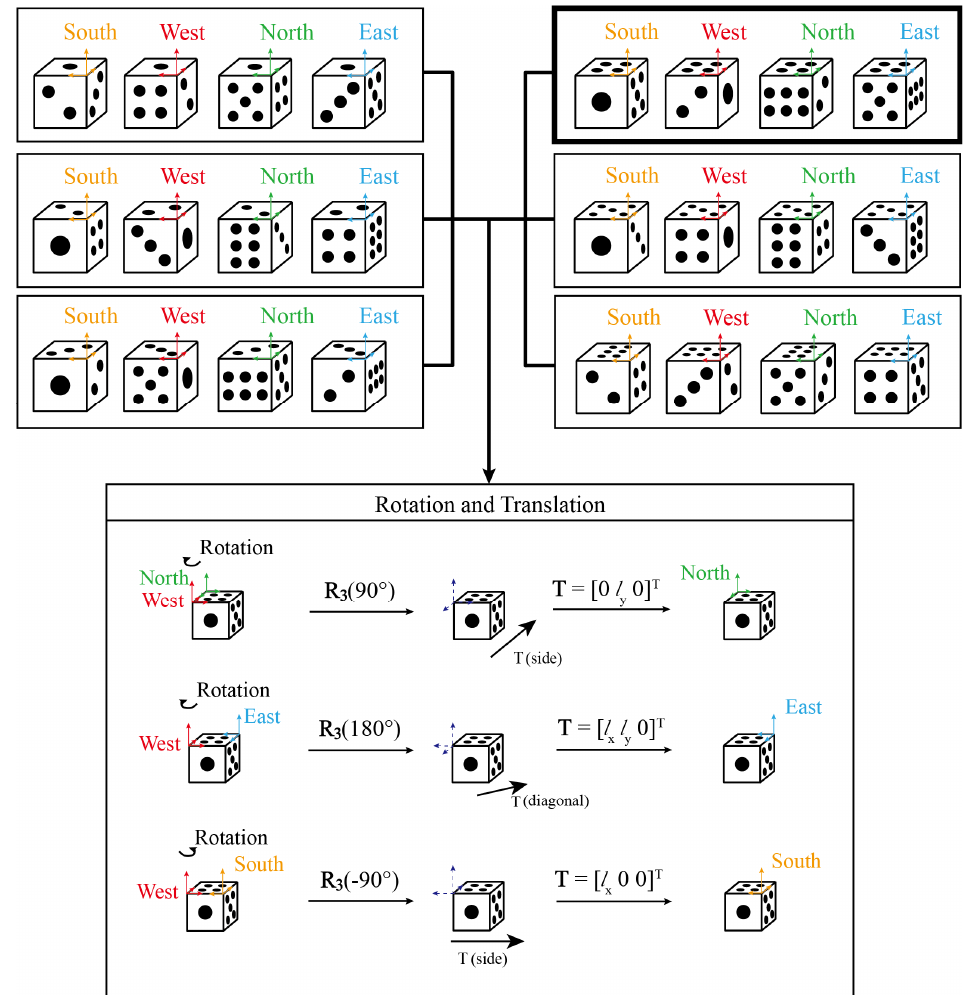
Figure 8. Twenty ‐ four constructed coordinate systems in the die space, and the